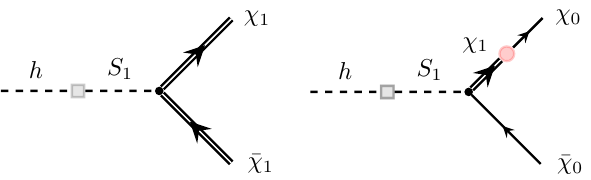
Fig. 5 Diagrams responsible for the generation of the Higgs coupling to DM in the two main scenarios discussed in the text. The left figure corresponds to the case where the DM candidate is the first KK mode of a single 5D fermion field. The right figure corresponds to the case where the different chiralities of the DM candidate are zero modes of different 5D fields and the mediation via heavy KK modes is